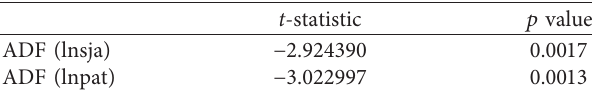
Table 3: Kao cointegration test